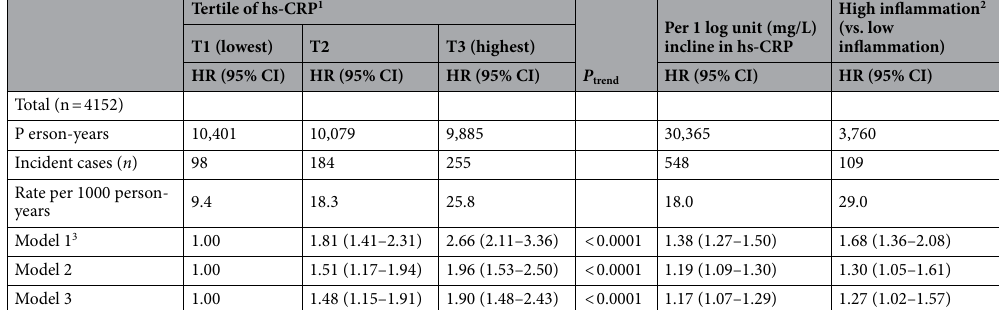
Tertile of hs-CRP 1